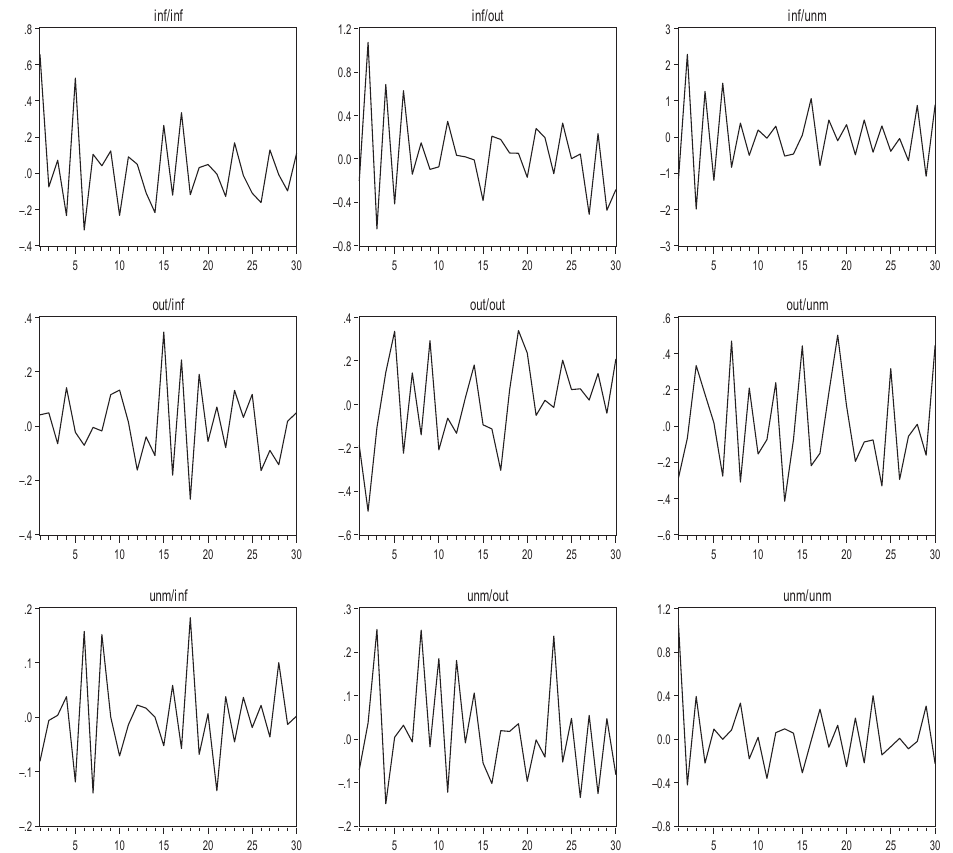
Fig. 1. Estimated short and long run impact multipliers for inflation/unemployment/output (short/long run elasticity of inflation/unemployment/output) Source: authors